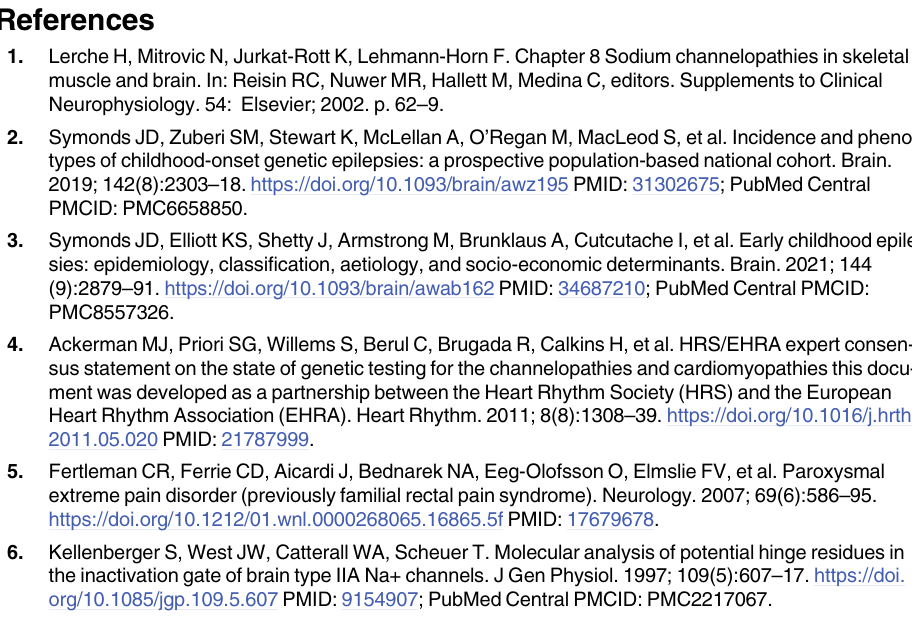
S2 Table. List and description of sequence- and structure-based features, sorted by column vectors in the training data set. Raw and preprocessed feature tables are available as part of our ‘Availability of data and materials’